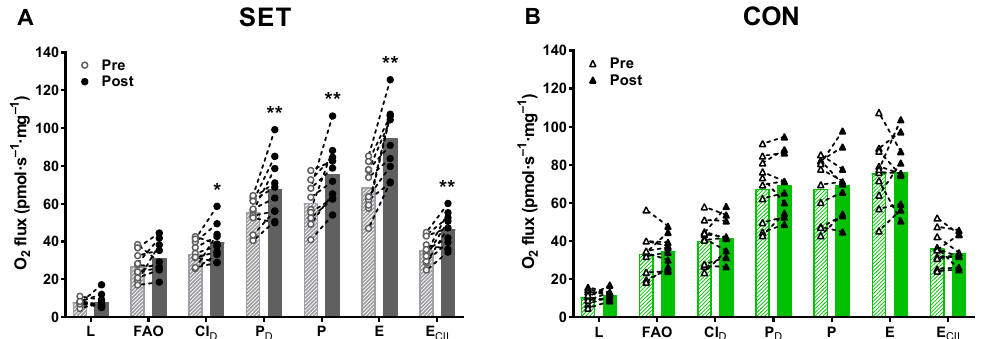
Figure 12. Effect of speed endurance training (SET) on mitochondrial respiratory capacity. Mito- chondrial respiratory capacity at different states before (pre) and after (post) SET (( A ), SET, n = 10) or habitual lifestyle maintenance (( B ), CON, n = 10). L, leak respiration; FAO, fatty acid oxidation; CI D , complex I-linked respiration at sub-saturating ADP concentration; P D , complex I+II linked respiration at sub-saturating ADP concentration; P, maximal complex I+II linked respiration; E, maxi- mal electron transfer-pathway capacity; E CII , complex II-linked electron transfer-pathway capacity. ** Post different from pre ( p < 0.01). * Post different from pre ( p < 0.05). Data are presented as mean with individual changes.